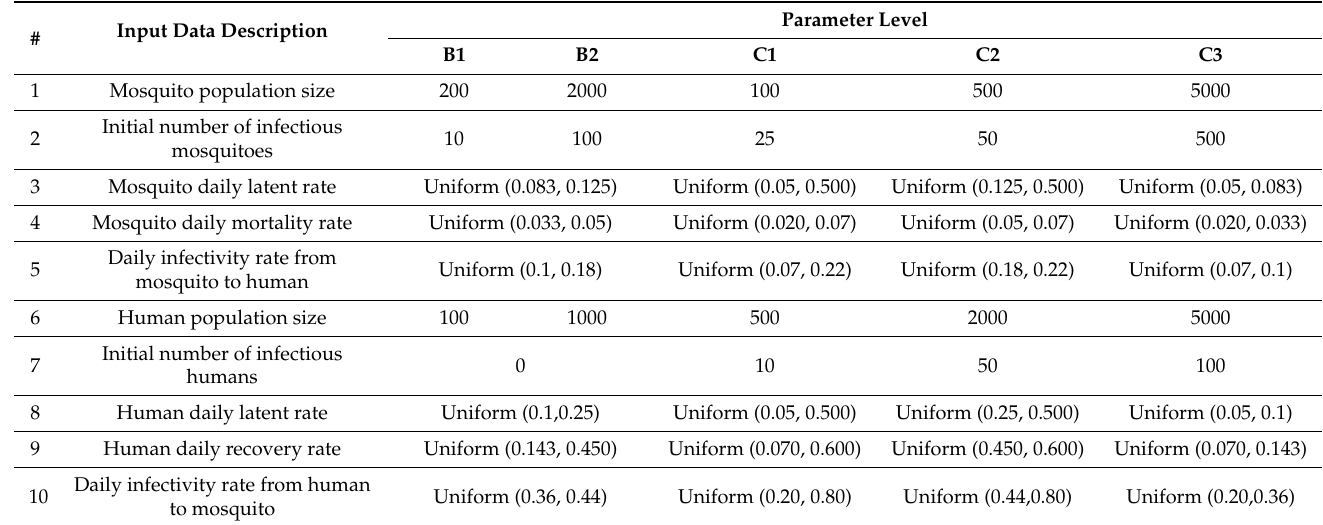
Table 5. Input parameter values of the simulation Model